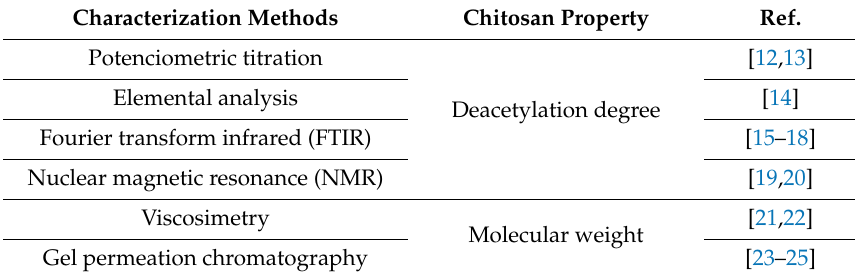
Table 2. Several characterization methods to evaluate the deacetylation degree and average molecular weight of chitosan.